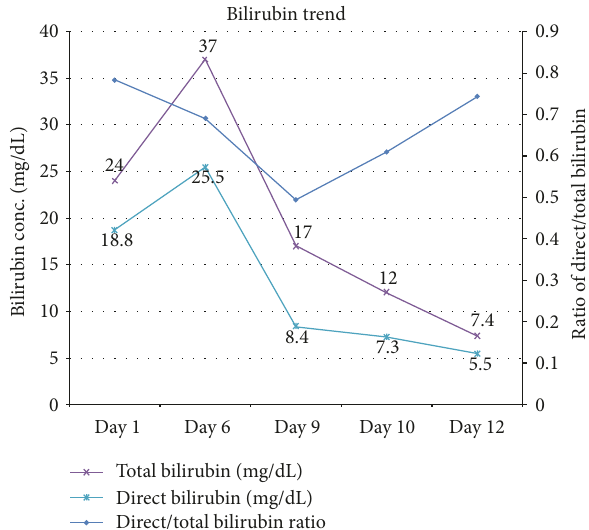
Figure 1: Trend of bilirubin (total and direct) during the course of hospitalization.